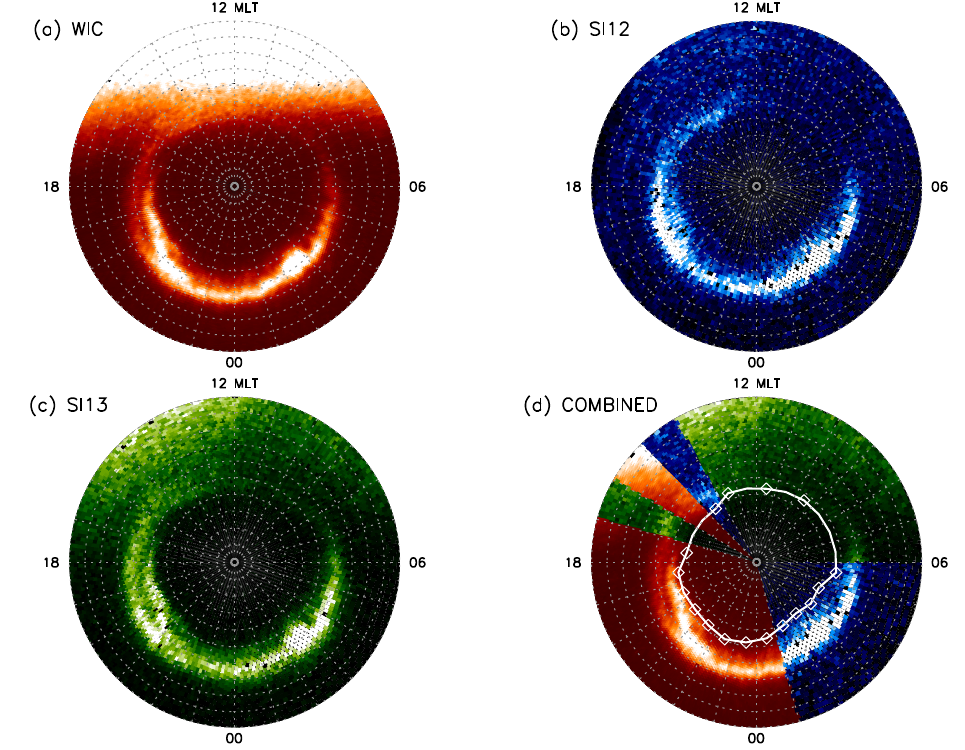
Fig. 10. FUV intensity observed by the IMAGE FUV instrument at 09:18 UT 28th October 2001 in AACGM coordinates. Panels (a) to (c) show the intensity values from the WIC, SI12, and SI13 cameras respectively. Panel (d) shows the composite intensities obtained when selecting the most appropriate camera for each MLT sector. The white diamonds in panel (d) show the OCB location estimates made using the method outlined in this paper from the selected camera. The correction offsets have been added to these OCB